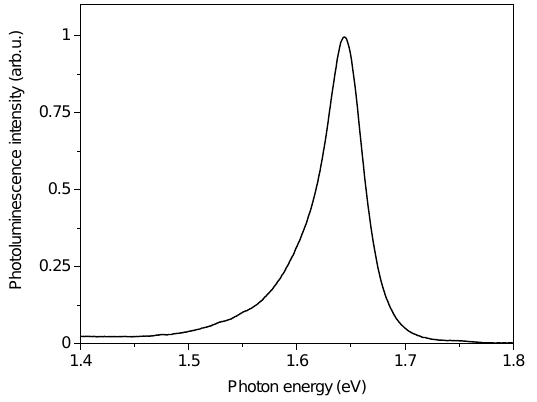
Figure A1. Photoluminescence spectrum of the 1sA exciton in the monolayer WSe 2 excited by a continuous wave laser at a photon energy of 2.33